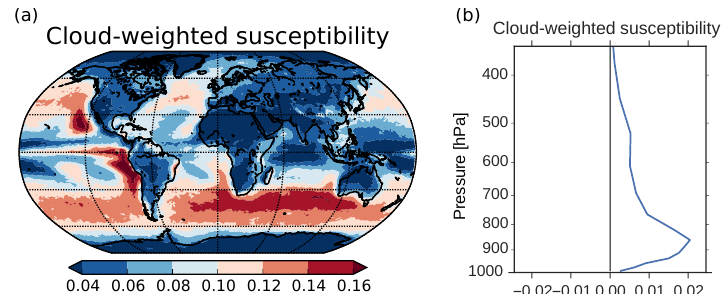
Figure 10. (a) Cloud-weighted susceptibility using Eq. (6) in Alterskjær et al. (2012). Cloud droplet size and numbers from the cloud top layer and the total cloud fraction were applied. (b) Vertical profile of the global mean cloud-weighted susceptibility.